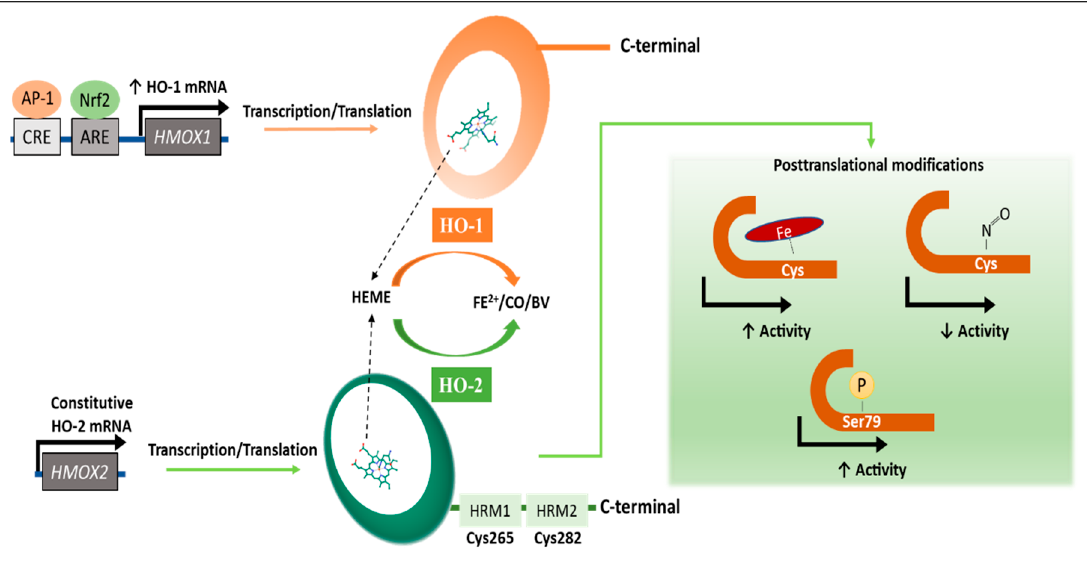
Figure 1. Regulatory mechanisms for the expression and activity of HO enzymes. Heme oxygenase 1 (HO-1) is induced by transcription factors, such as Nrf2 and AP-1, as schematically shown in the figure. Heme oxygenase 2 (HO-2) binds to Fe 2+ ion of the heme group through cysteine residues in the heme regulation motifs (HRMs) of the enzyme, inducing its activity (up-arrow). Additionally, phosphorylation of serine 79 residue enhances the enzymatic activity (up-arrow). In addition, nitrosylation of the cysteine residue inhibits enzyme activity (down-arrow). Both isoforms catalyze the oxidation of the heme group producing Fe 2+ , CO, and biliverdin (BV).